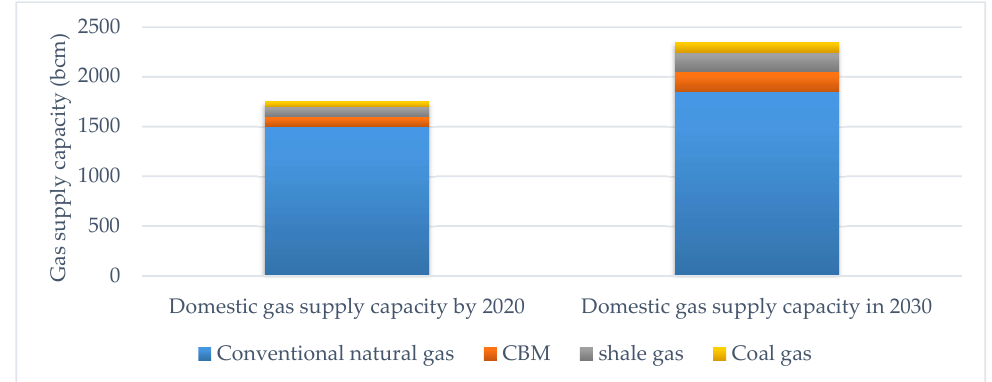
Figure 3. Domestic natural gas supply capacity and structure in 2020 and 2030.